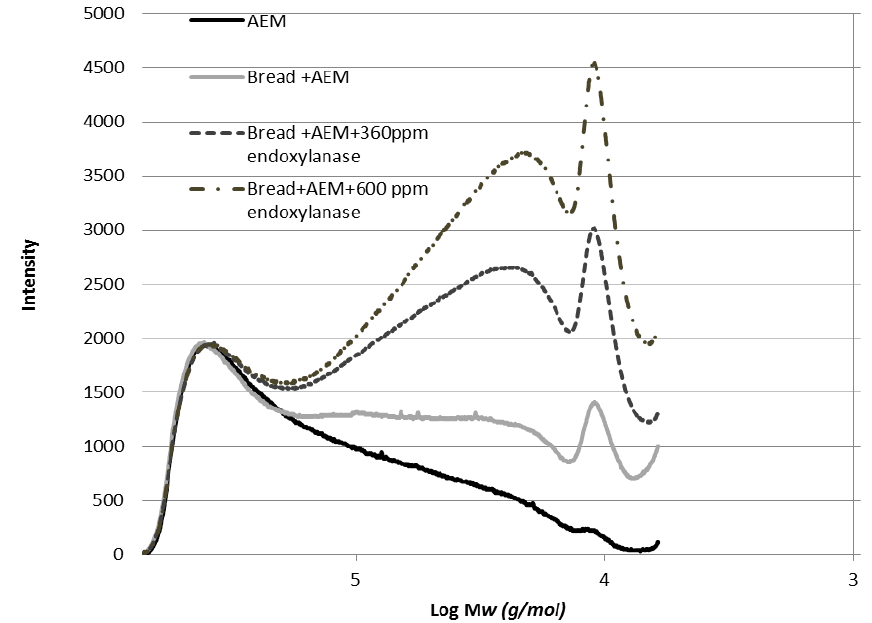
Figure 5. Molecular distribution of AX in AEM, bread + AEM, bread + AEM